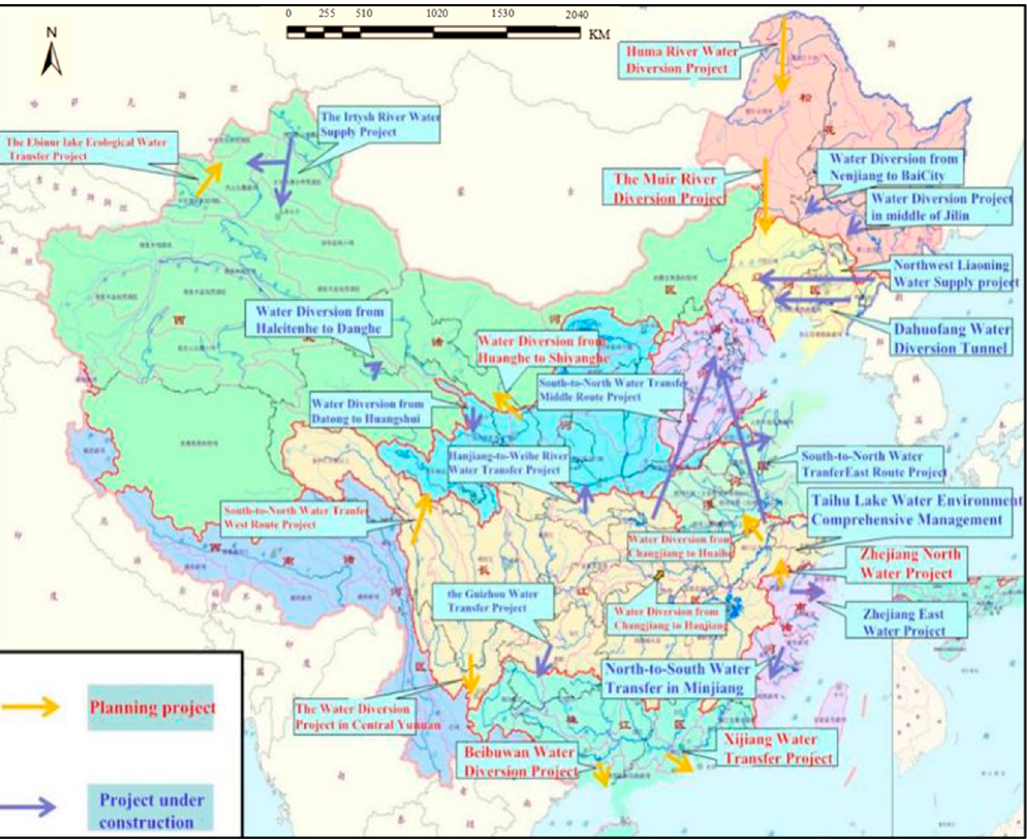
Figure 1. Layout plan for water diversion projects in China (red: planning project; blue: project under construction).